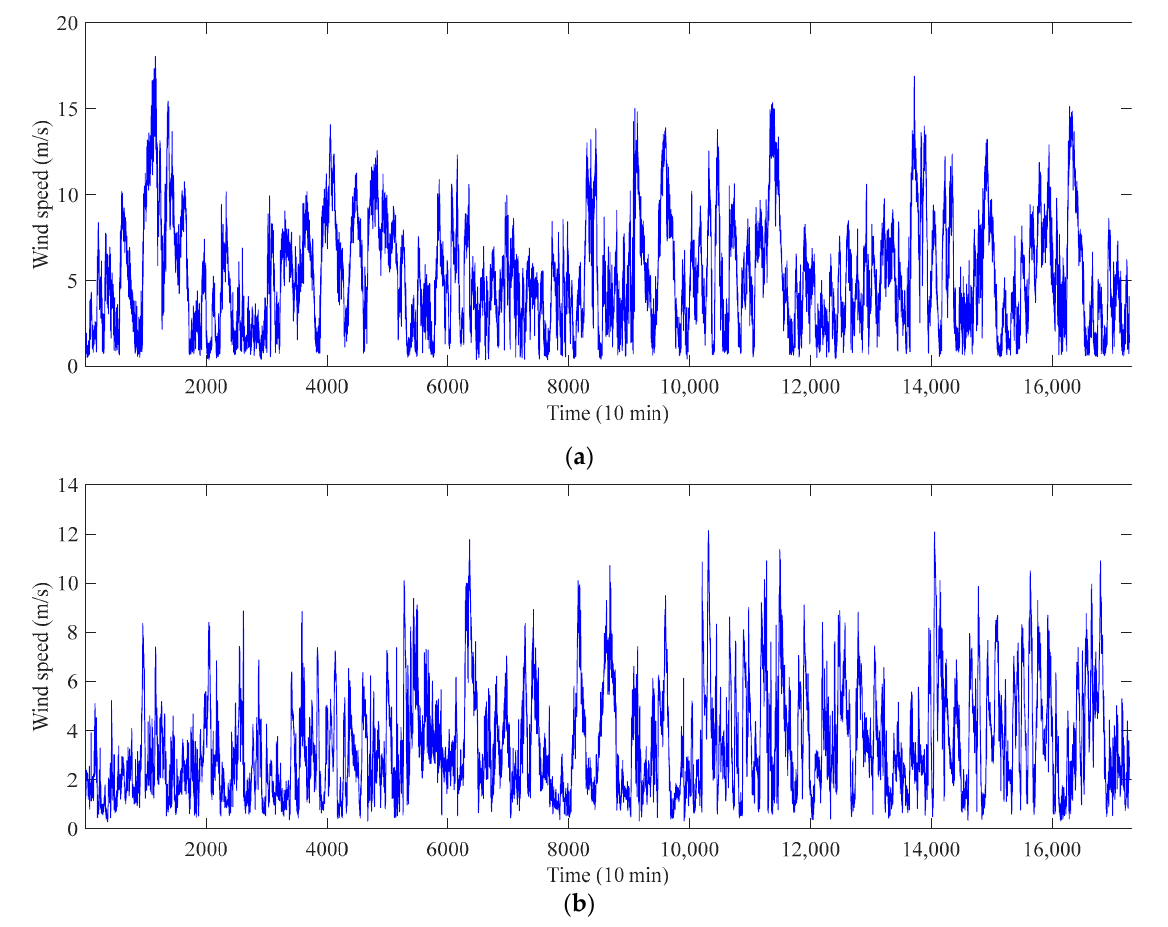
Figure 5. Time history plots of 10 min average wind speed data of the A2018 and B2019: ( a ) A2018; ( b ) B2019. Table 2. Descriptive statistics of 10 min average wind speed data of the A2018 and B2019.